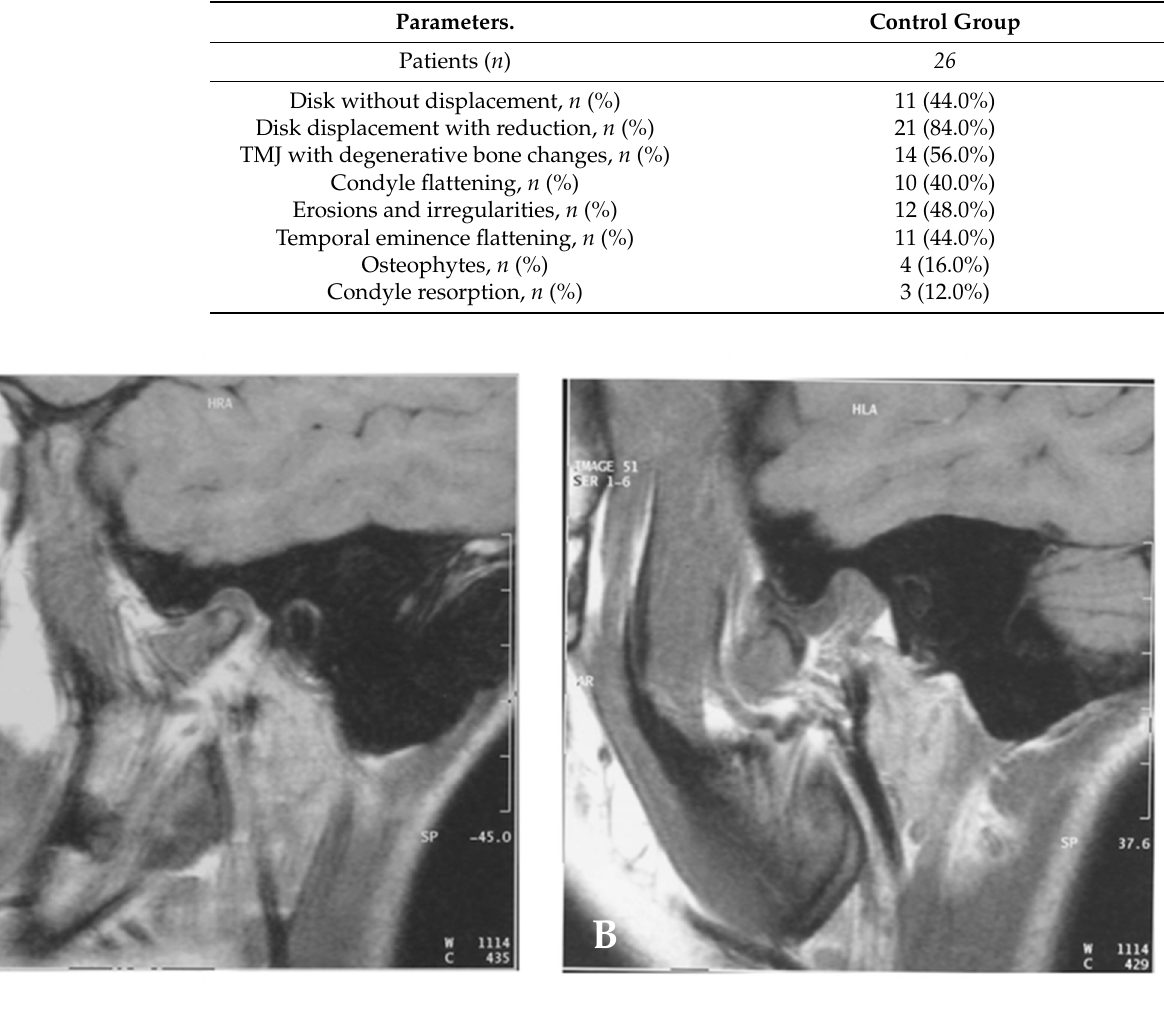
Figure 3. MRI of the right TMJ shows a meniscus which, although thin, is normally positioned between the bony heads with both open mouth ( A ) and closed mouth ( B ). In the closed-mouth study, anterior dislocation of the meniscus is documented with subsequent recapture of the same in the open-mouth study, a finding compatible with a condylar-meniscal incoordination syndrome. The MRI examination also documented a modest hypotrophy of masticatory muscles on the right.